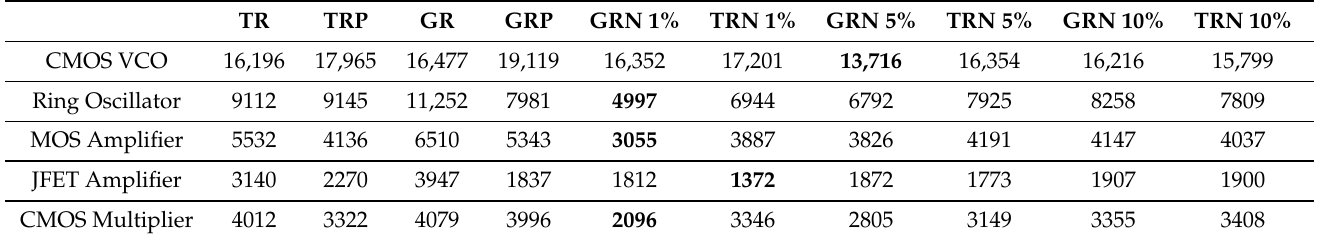
Table 1. Time required for pivoting, reordering, and factorization for different sizes of sparse